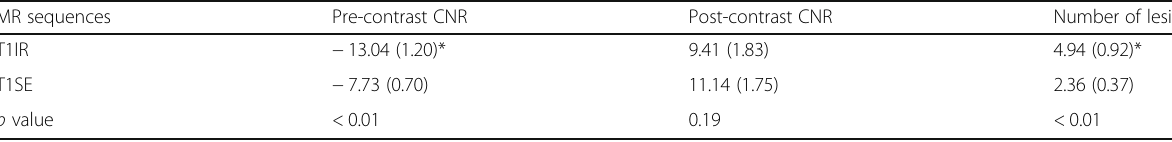
Table 1 Difference between T1IR and T1SE in CNR and number of lesions MR